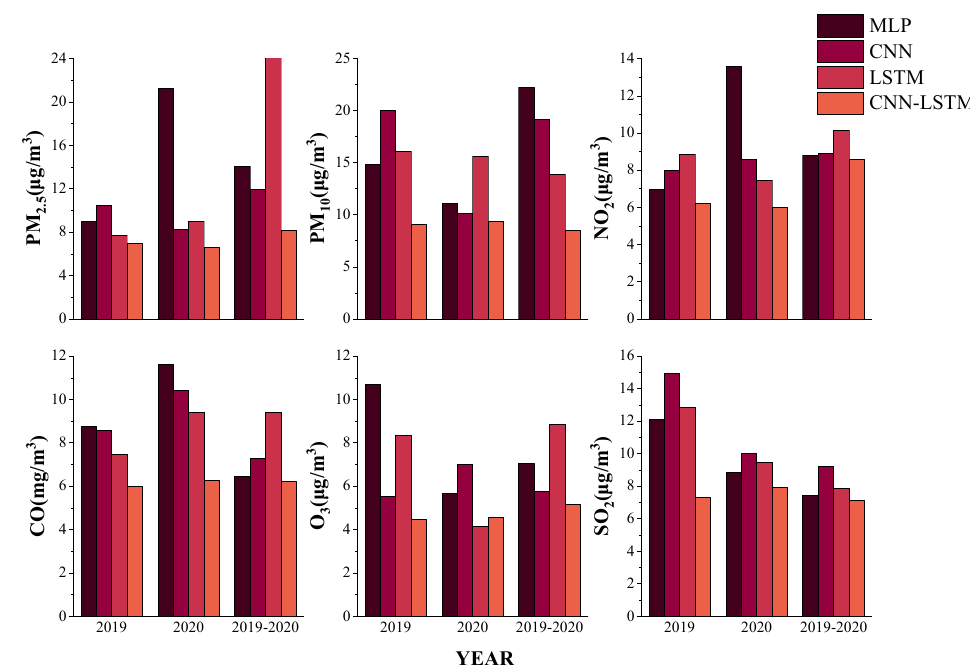
Figure 11. Comparison of the four models predicted MAPE for six air pollutants in 2019, 2020, and 2019–2020.